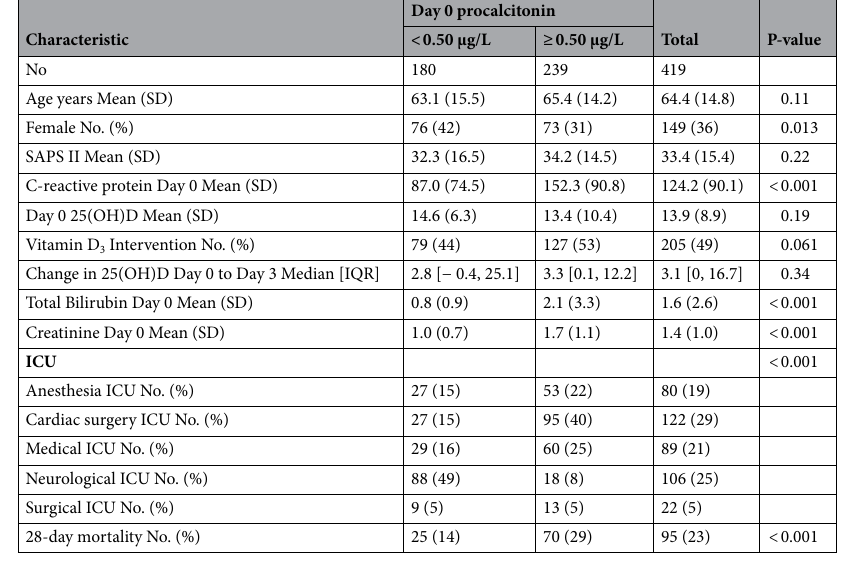
Table 1. Analytic cohort characteristics by Day 0 procalcitonin